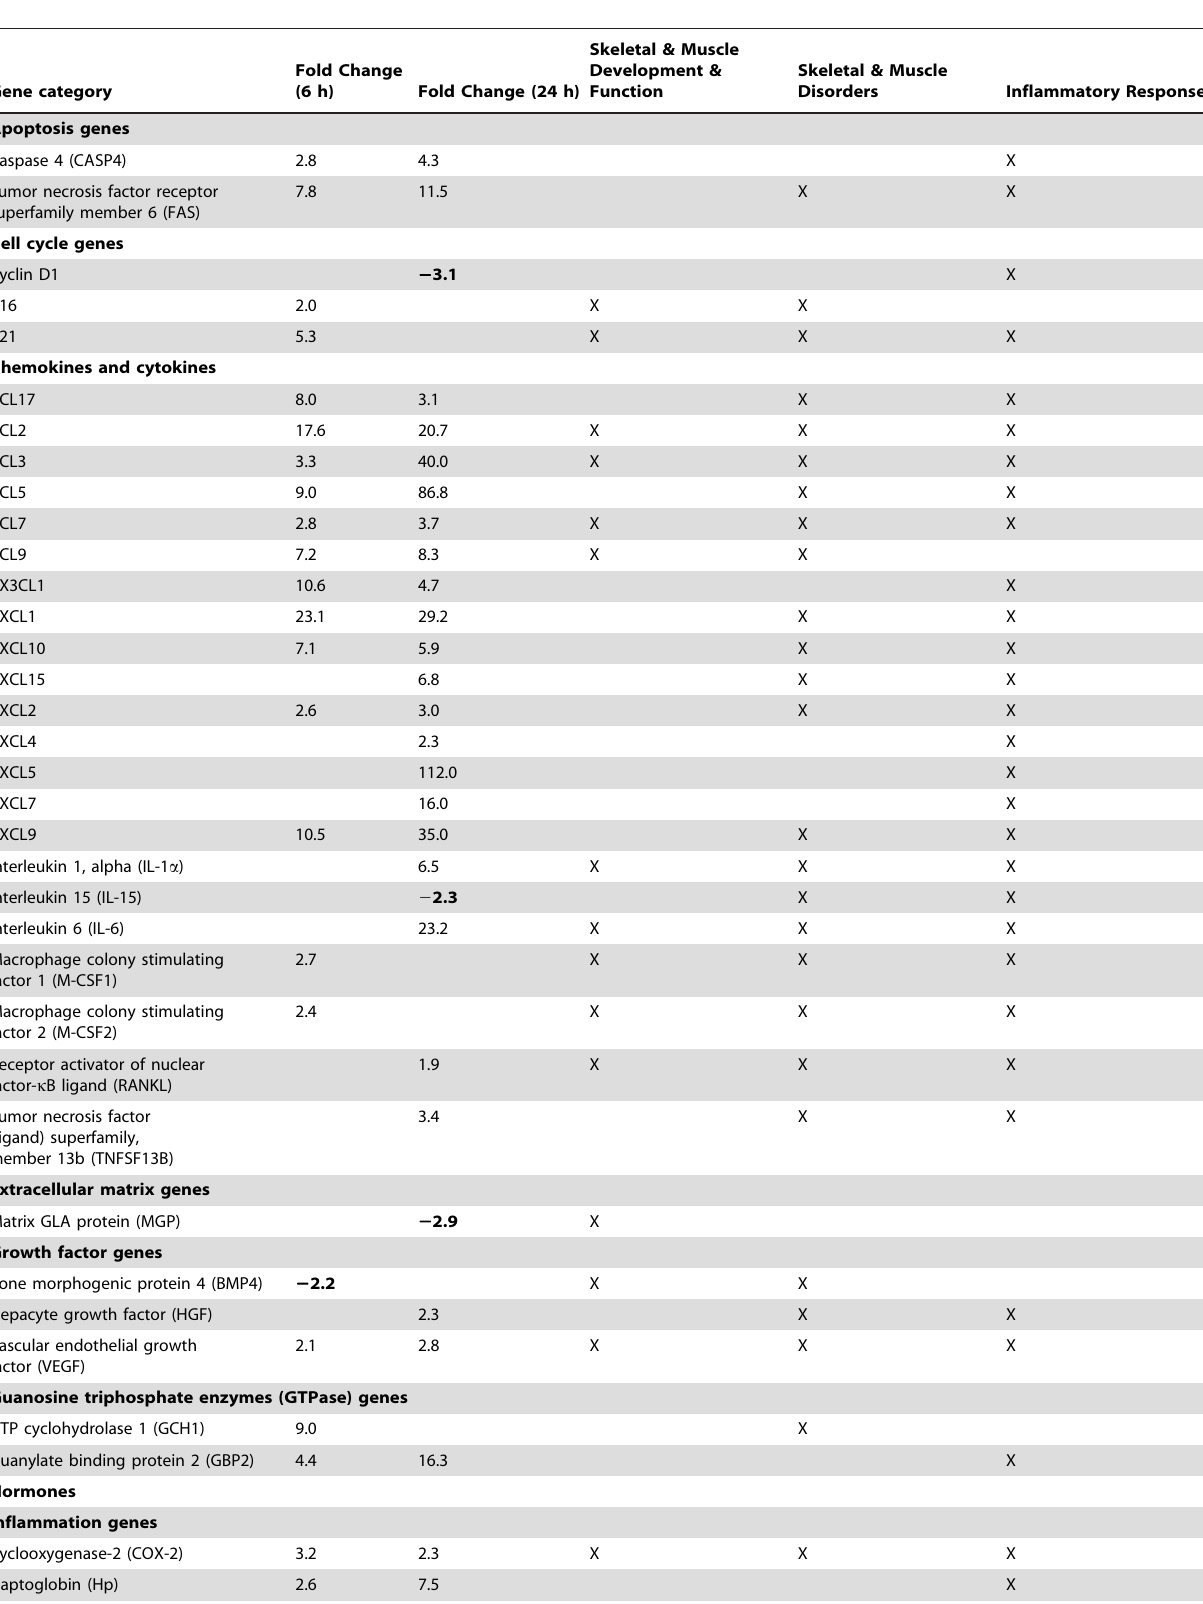
Table 2. Genes regulated by P. gingivalis and associated with the categories of Skeletal/Muscle disorders and inflammatory